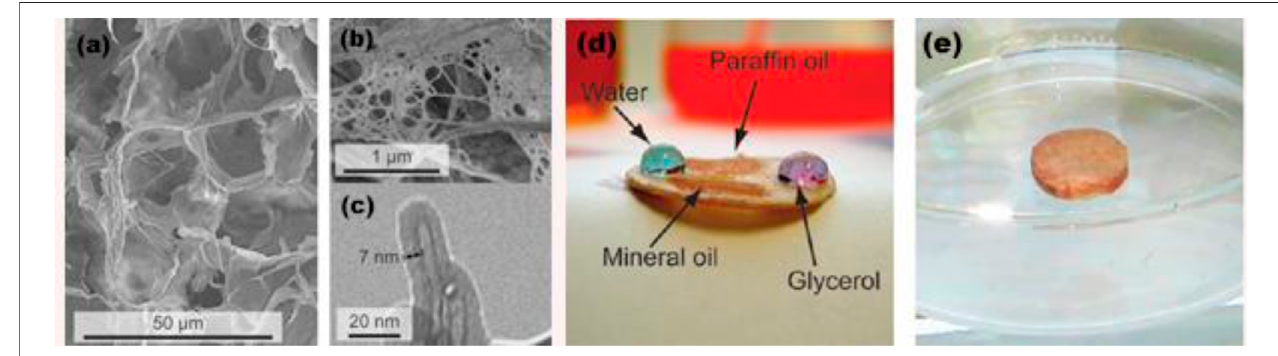
FIGURE7 | Microstructure of natural nanocellulose aerogels. (A) SEM image offreeze-dried nanocellulose aerogels, with fi brils packed into sheets and connected toformanopen,porousaerogelstructure. (B) Magni fi cationofananoporous fi brilsheet. (C) TEMimageofananocellulose fi brilcoatedwithTiO 2 (7 nm). (D) TiO 2 -coated aerogels are hydrophobic and oleophilic: the water and glycerol keep droplets (colored with Reactive Blue dye for clarity), whereas paraf fi n oil and mineral oil are readily absorbed. (E) Coated aerogel fl oating on water. Reprinted with permission from the Korhonen et al. (2011). Copyright (2011) American Chemical Society.